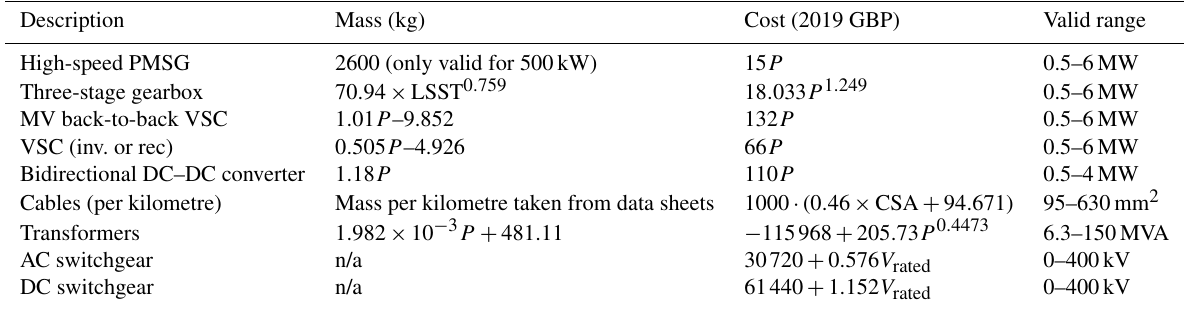
Table 2. Summary of mass and cost estimations of each component for variable-speed, pitch-regulated wind turbines. Description